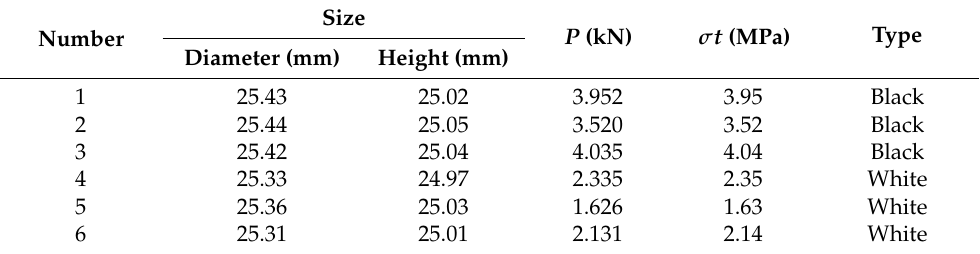
Table 2. Data of Brazilian splitting